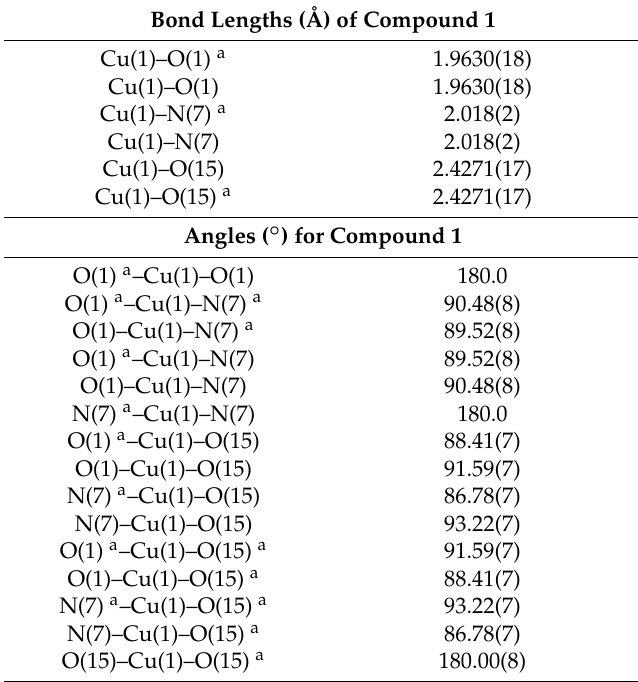
Table A2. Coordination bond lengths (Å) and angles ( ◦ ) for compound 1 .